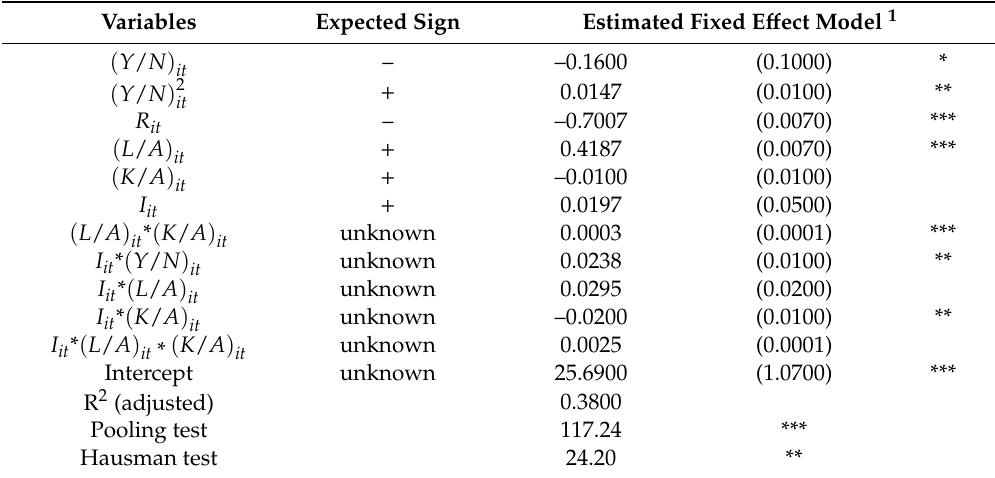
Table 2. Expected signs, estimated coe ffi cients, standard errors, and significance levels of the Environmental Kuznets Curve (EKC) model of global total forest